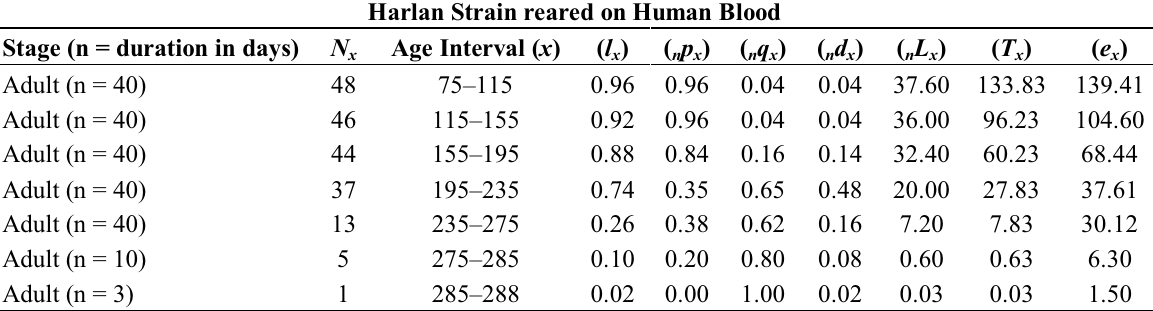
Table 1. Cont. Harlan Strain reared on Human Blood